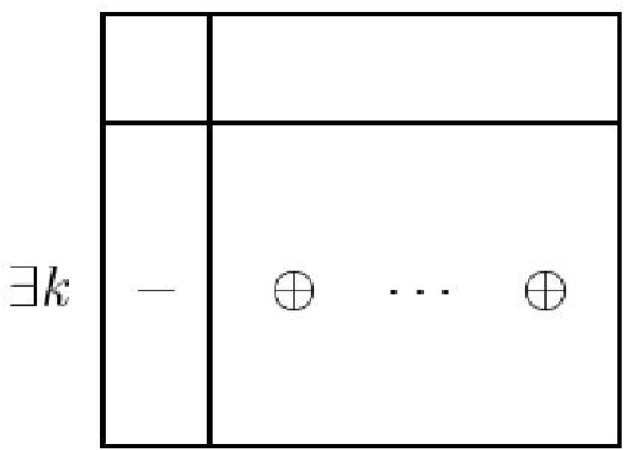
A short simplex table structure showing inconsistency of primal problem.